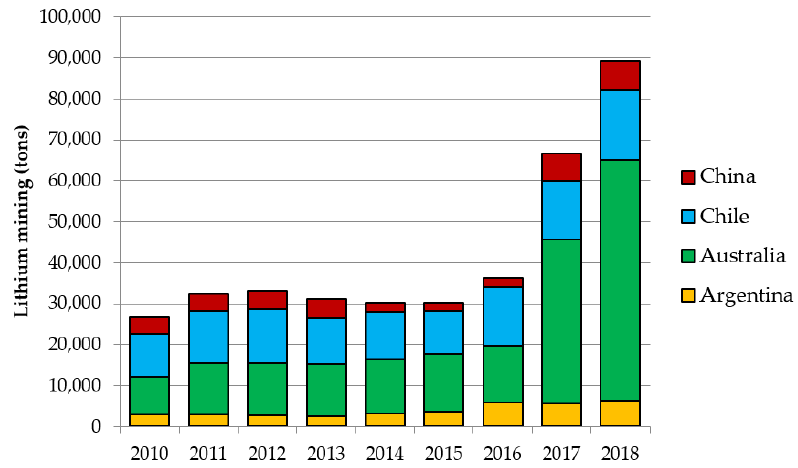
Figure 2. Production of lithium from mining in the first four countries. The authors’ elaboration on